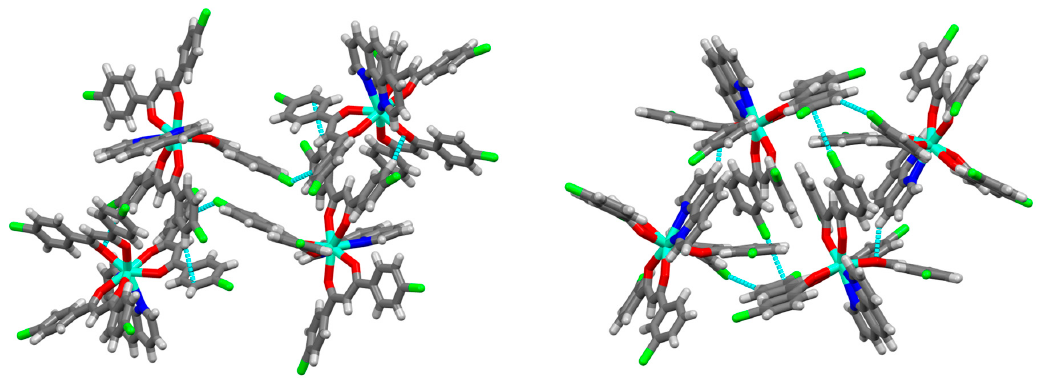
Figure 9. Unit cell of [Eu( pp -dbm-Cl 2 ) 3 phen] (left) and [Eu( mm -dbm-Cl 2 ) 3 phen] (right).